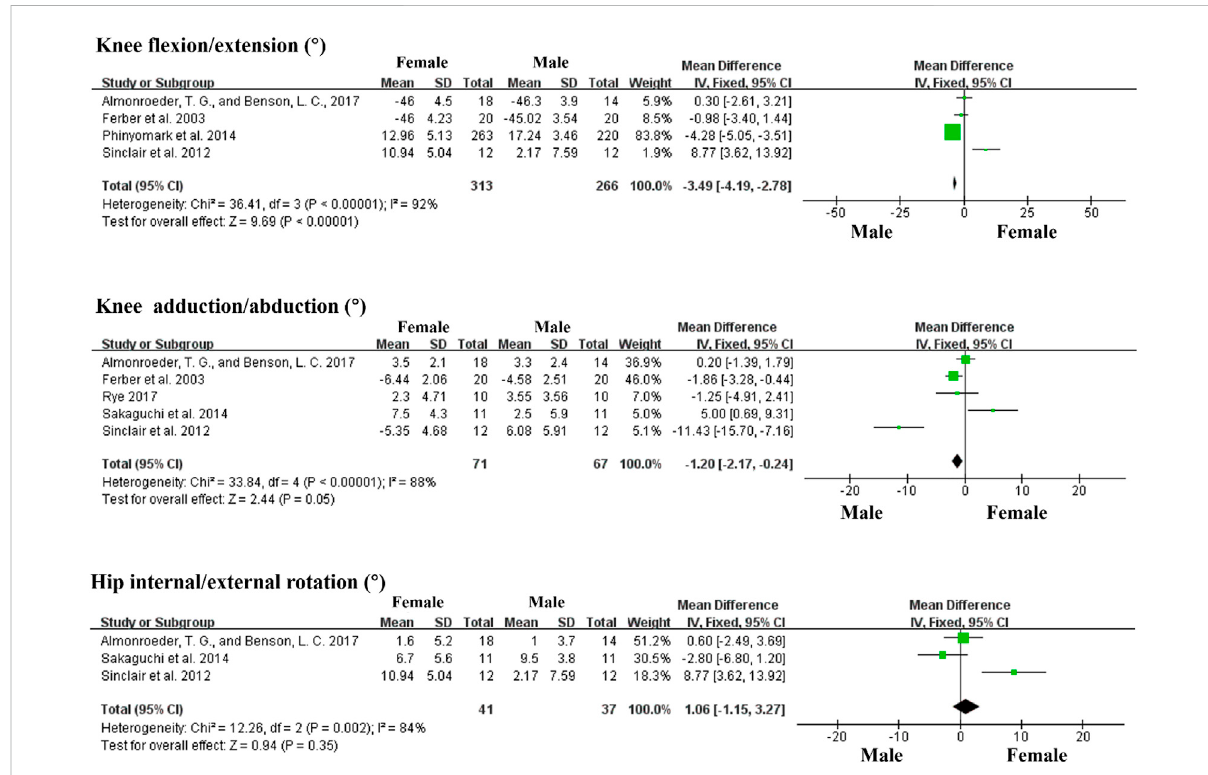
FIGURE 3 Forest plots displaying a kinematic comparison of the knee joint between female and male runners during